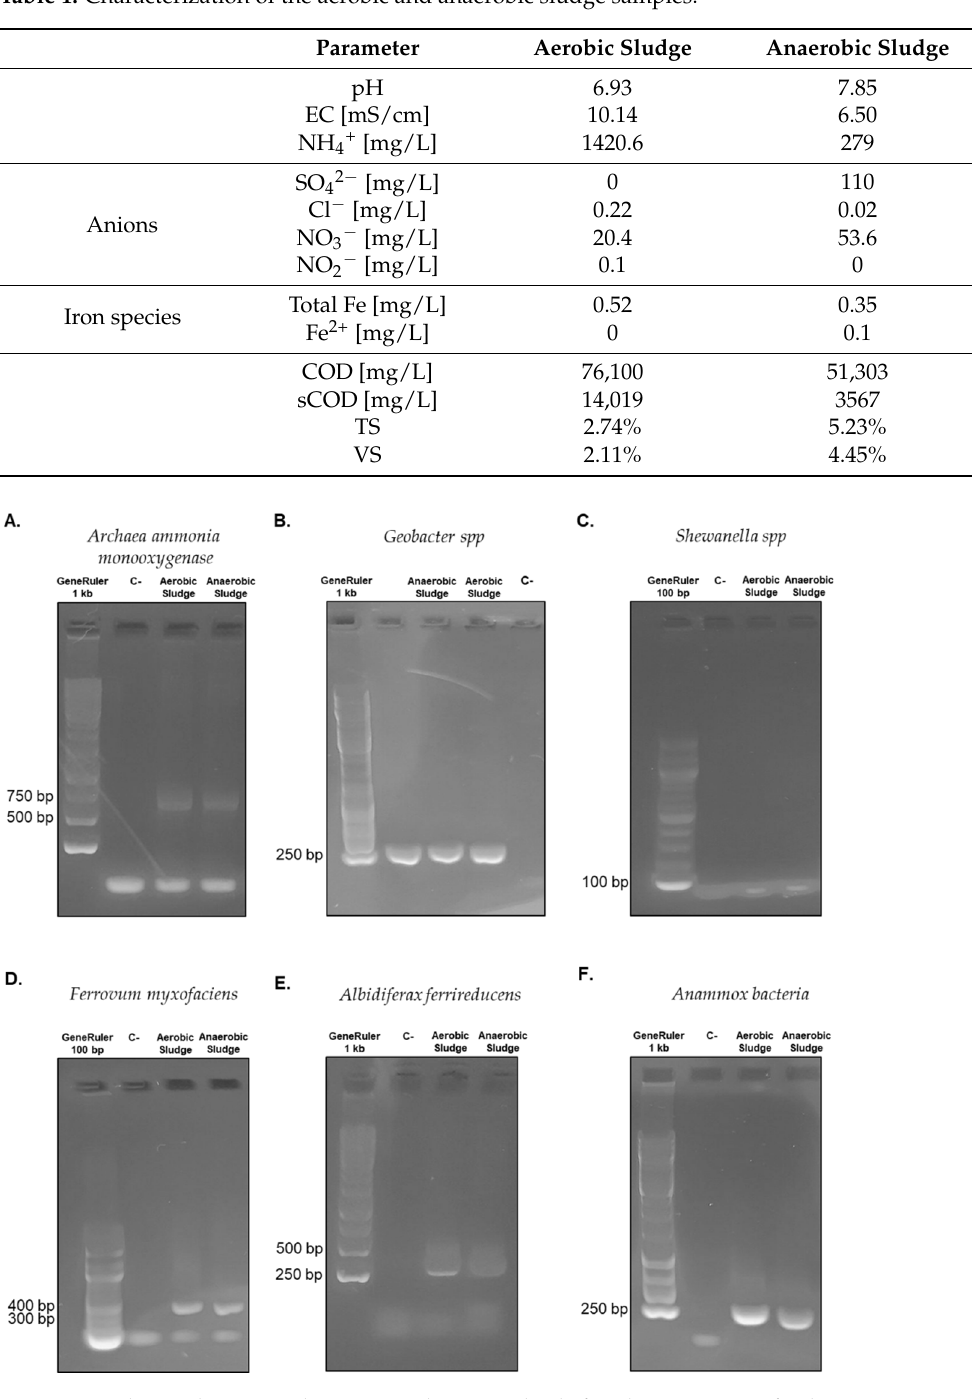
Table 1. Characterization of the aerobic and anaerobic sludge samples.